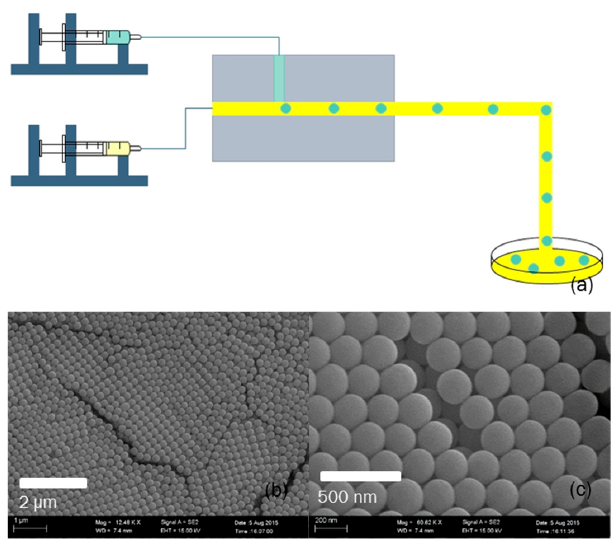
Figure 7. ( a ) The structure of the microfluidic device. ( b , c ) The SEM images of monodispersed colloidal silica nanoparticles.